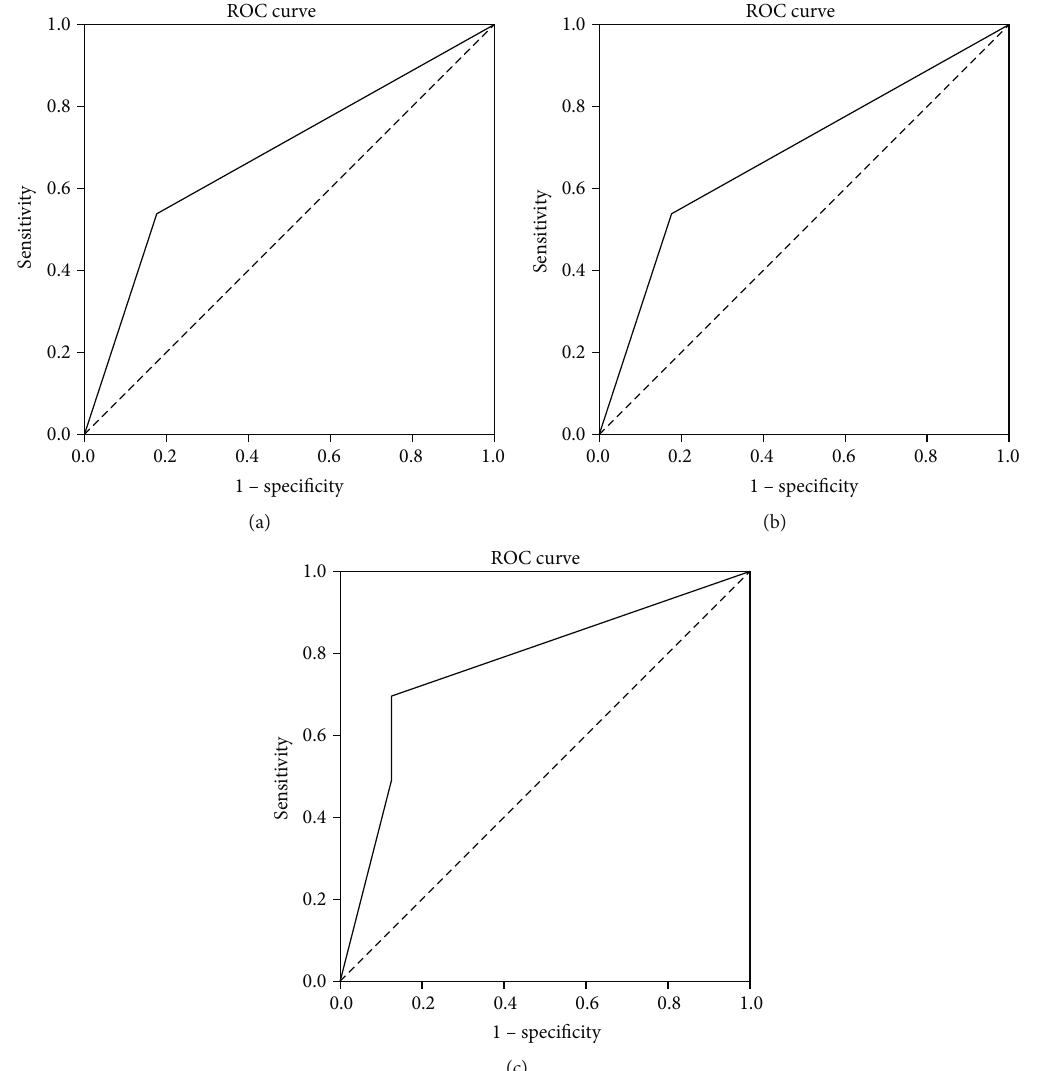
Figure 4: ROC of diagonal segments. (a) ROC of diagonal segments is produced by ties of DSG1 in EHCC. (b) ROC of diagonal segments is produced by ties of DSG2 in EHCC. (c) ROC of diagonal segments is produced by ties of DSG1 and DSG2 in